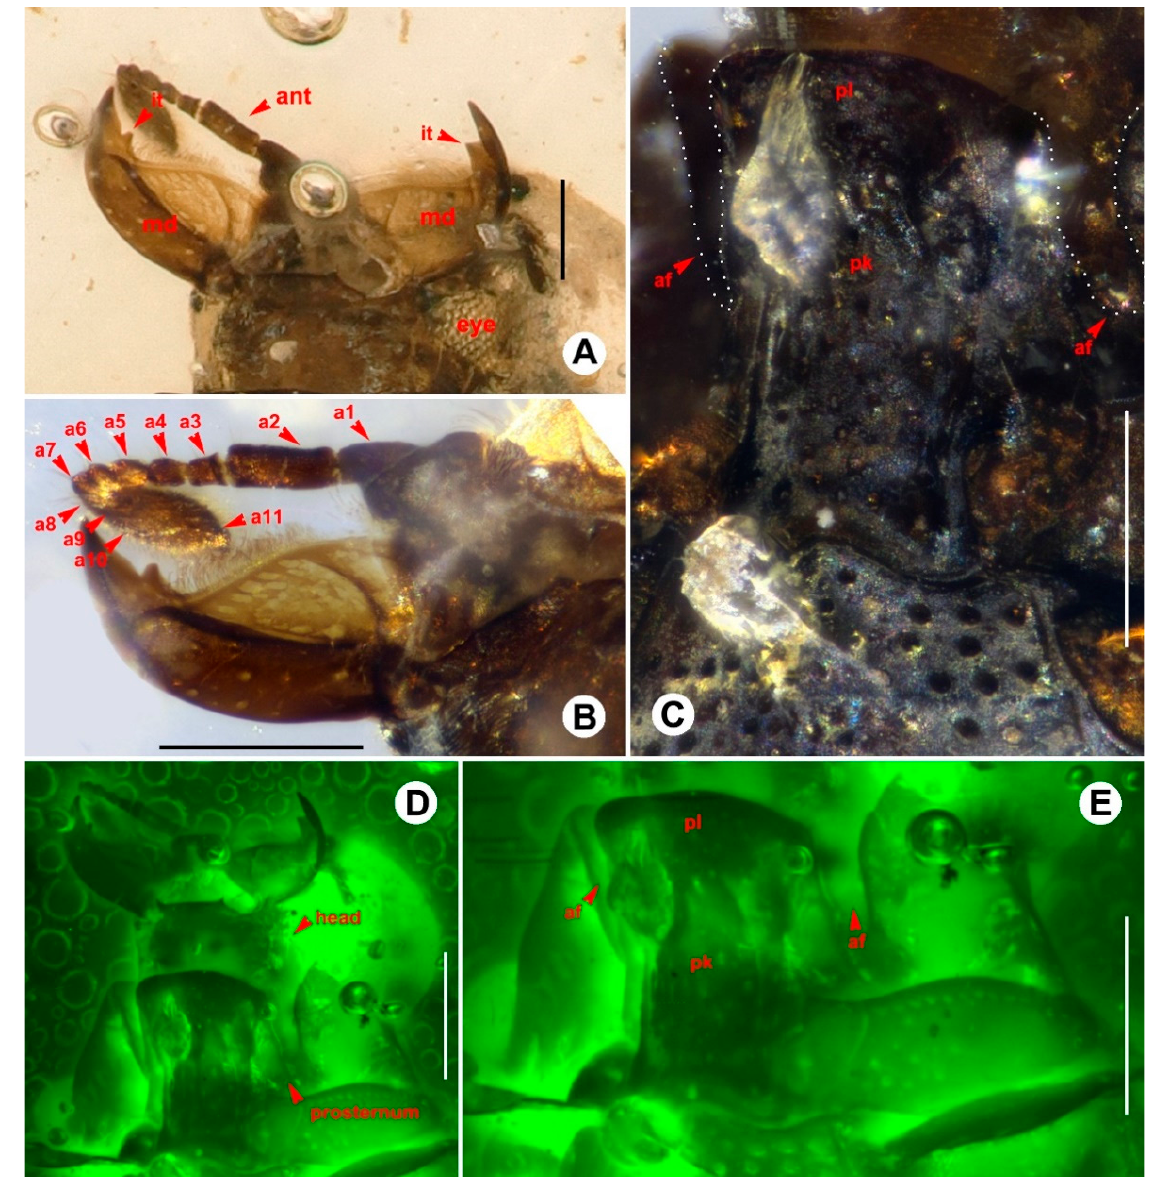
Figure 2. Diagnostic features of Anapleus kachinensis sp. nov., holotype, GUGC-FOSSIL-0002. ( A ) Mandible. ( B ) Antenna. ( C) Prosternum. ( D ) Head and prosternum, under green fluorescence. ( E ) Prosternum, under green fluorescence. Scale bars: 0.1 mm. Abbreviations: ant, antenna; a1–11, antennomere 1–11; md, mandible; it, inner tooth; af, antennal fissures; pk, prosternal keel; pl, prosternal lobe.